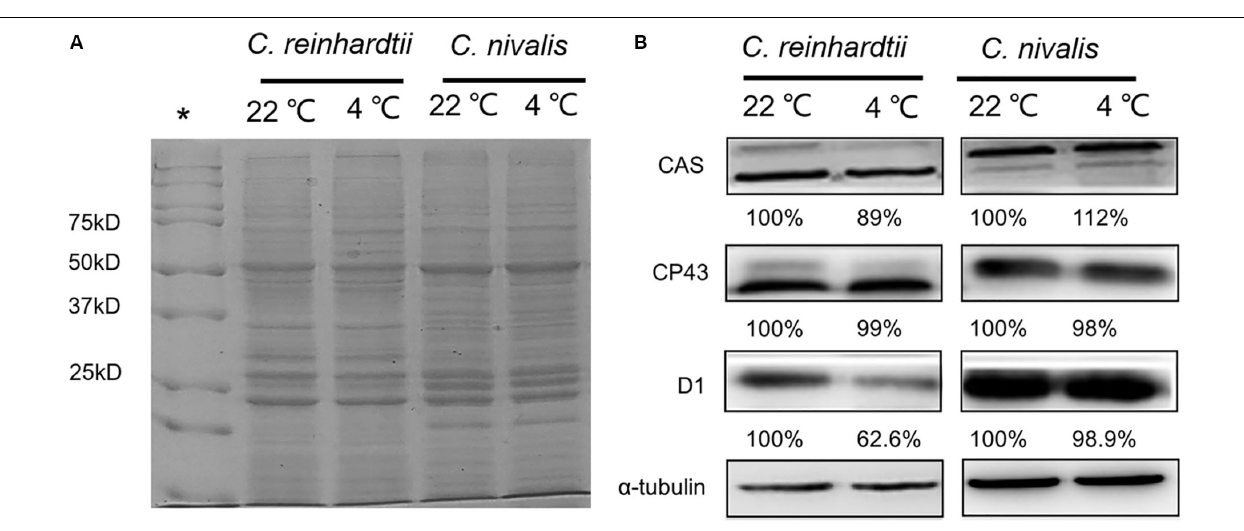
FIGURE 4 | Protein level and relative protein abundance. (A) Representative image of SDS-PAGE analysis of total proteins extracted from C. nivalis and C. reinhardtii at 22 and 4 ◦ C as the loading control in the immunoblot analysis. A 20 µ g aliquot of proteins from each sample was separated on a 12% SDS-PAGE gel and stained with Coomassie Brilliant Blue. (B) Relative protein abundances of the CAS, CP43, D1, and reference protein α -tubulin. *: